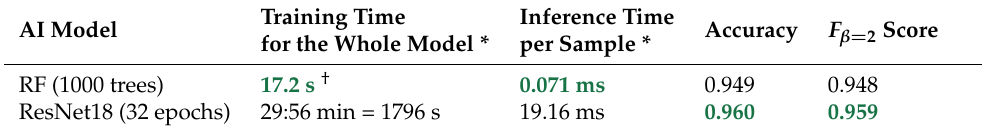
Figure 17. Comparison between confusion matrices of ( a ) RF and ( b ) ResNet. Darker colors indicate more allocation of the predicted and actual class combinations: ideally, the matrix should only have values on the diagonal. Table 2. Performance and training speed comparison between RF and ResNet